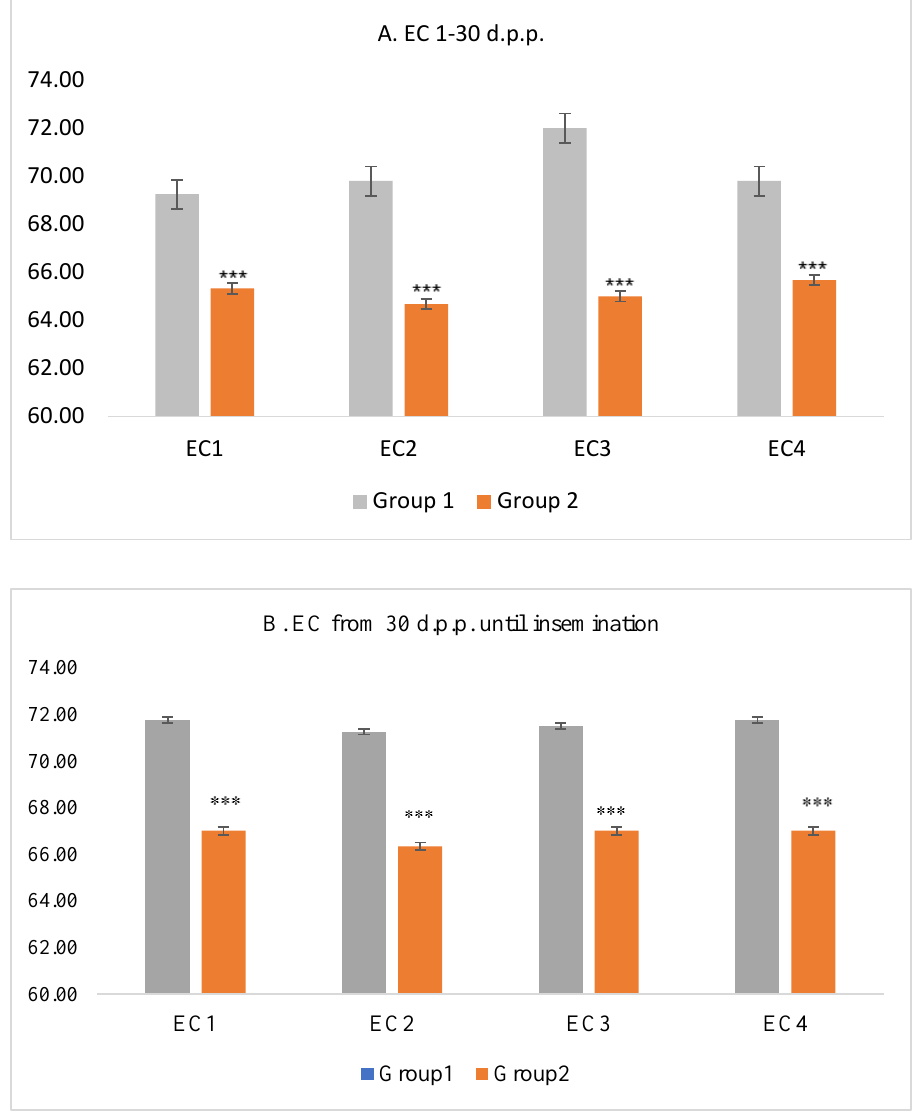
Figure 2. Electrical conductivity of cows’ milk at the level of udder quarters (μS/cm). ( A ). 1–30.p.p., ( B ). From 30 d.p.p. until insemination. Group 1—milk lactose < 4.70%, Group 2—milk lactose ≥ 4.70%. EC1—rear right, EC2—rear left, EC3—front right, EC4—front left. The difference between the groups is statistically significant—*** P < 0.001.